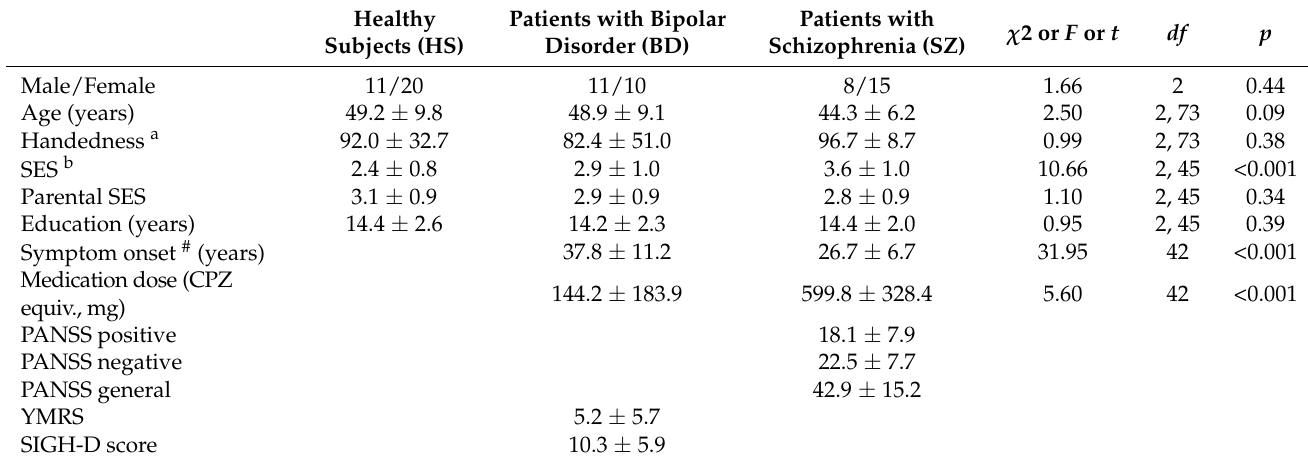
Table 1. Demographic and clinical characteristics of the